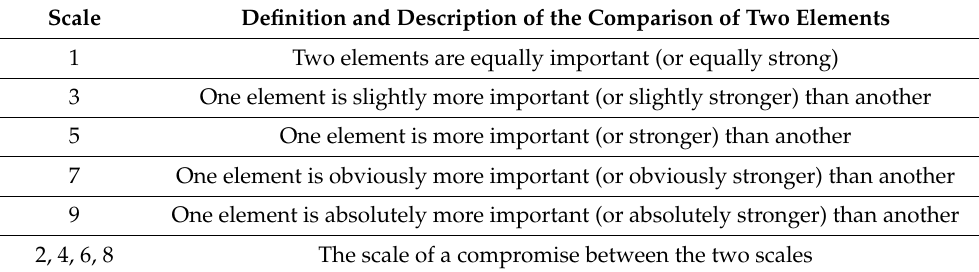
Table 3. Judgment comparison scale